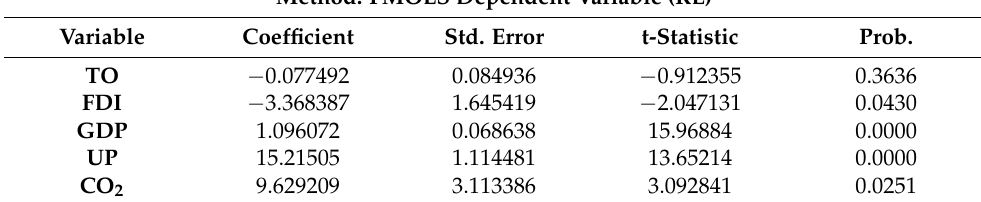
Table 7. FMOLS Table.